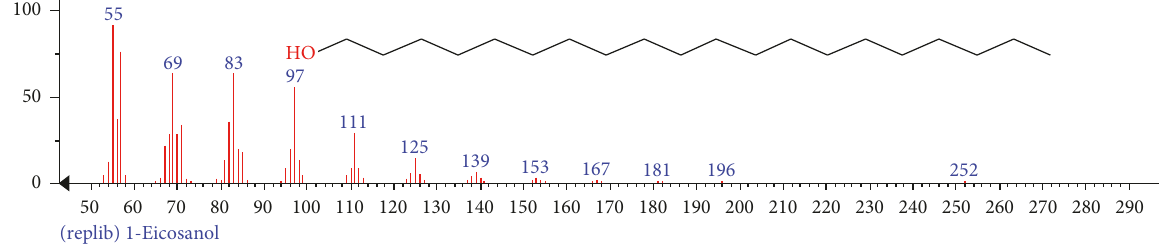
Figure 47: Mass spectrum of compound 1-eicosanol of whole plant hexane fraction of Achillea wilhelmsii (WHFAW).